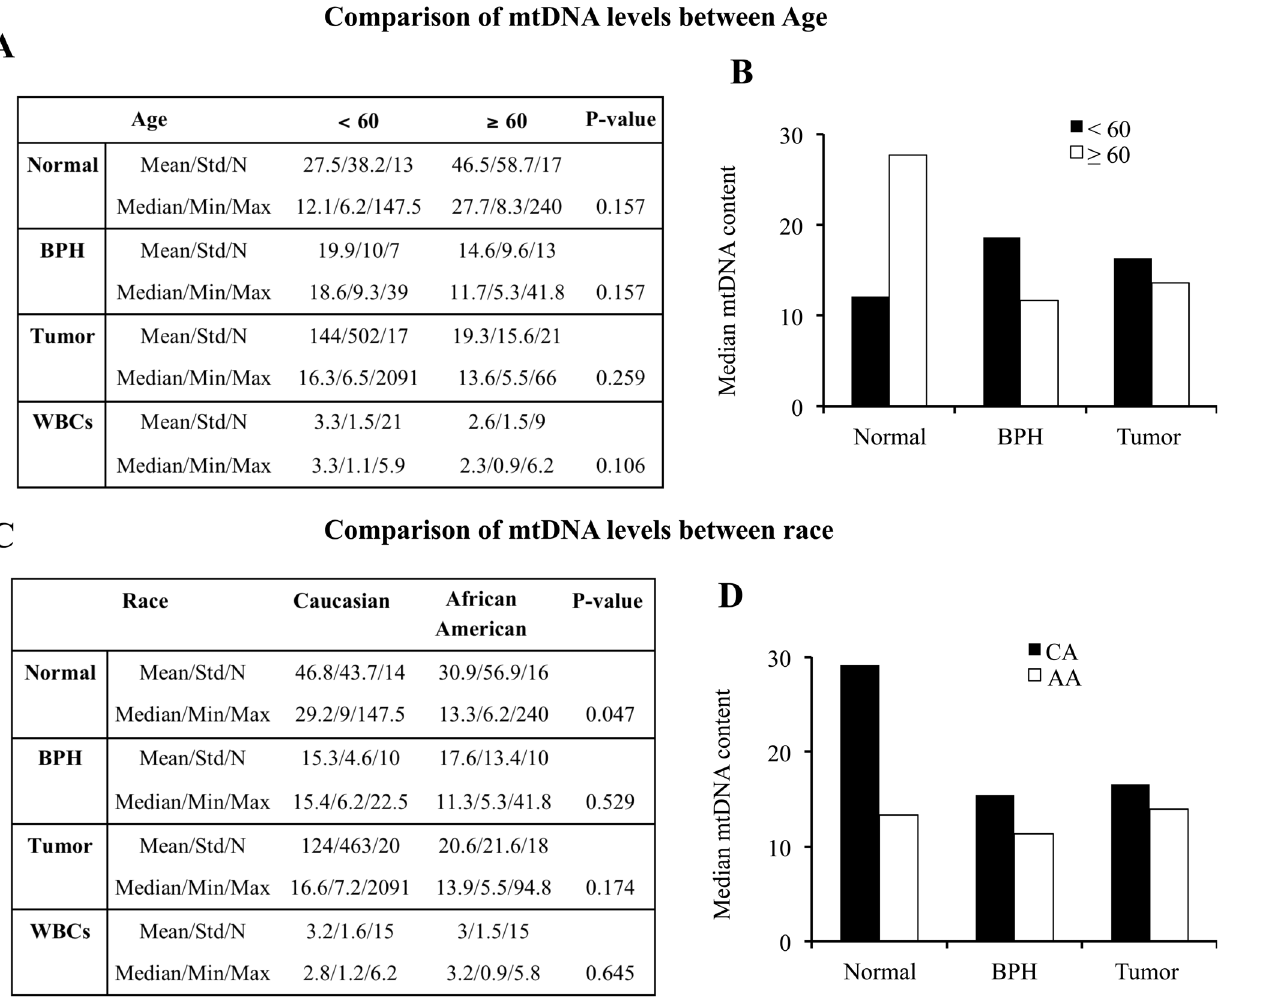
Figure 1. Comparison of mtDNA content between age and race. A, mtDNA content was compared by age using Wilcoxon rank-sum test. B, Median mtDNA content in normal, BPH, and tumors from patients , 60 and $ 60 years of age are plotted for comparison. C, mtDNA content was compared by race using Wilcoxon rank-sum test. D, Median mtDNA content in normal, BPH, and tumors from AA and CA patients are plotted for comparison.